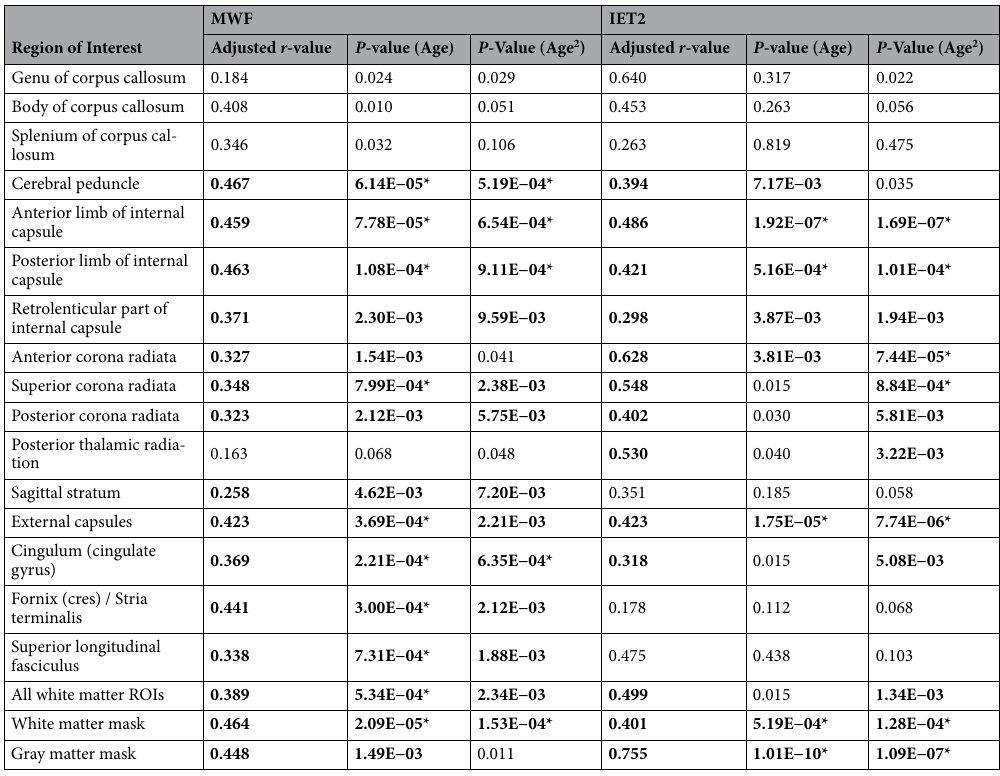
Table 2. Coefficients and P -values for multiple linear regression between a quadratic polynomial in age and mean myelin water fraction (MWF), and between a quadratic polynomial in age and mean geometric mean T 2 of intra- and extra-cellular water (IET2), for each region of interest. Statistically significant linear (age) and quadratic (age 2 ) contributions to the regression model are bold for P < 0.01 and bold* for P <